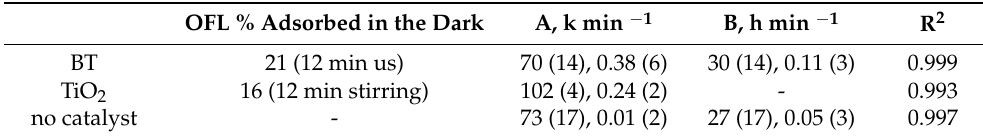
Table 1. % OFL adsorbed during the stirring in the dark, kinetic degradation constants and pre- exponential factors, for BT and TiO 2